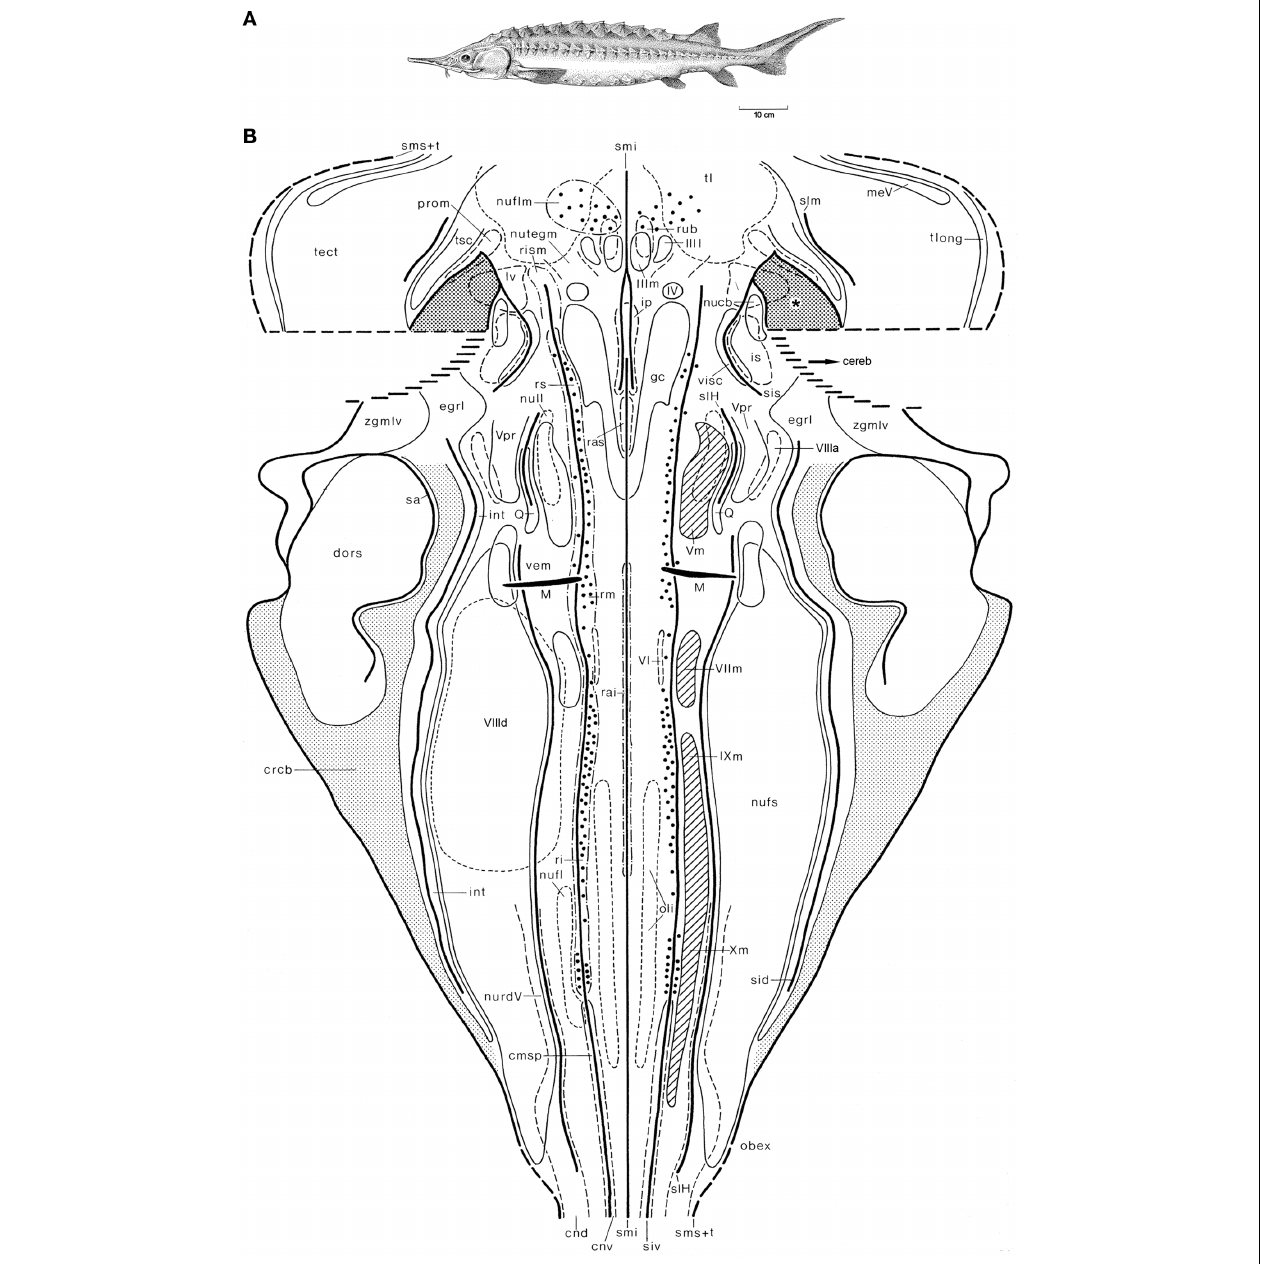
FIGURE 5 |The shovelnose sturgeon Scaphirhynchus platorynchus . Holotype (A) , and topological chart of the brainstem (B) . Modified from Nieuwenhuys (1998c).